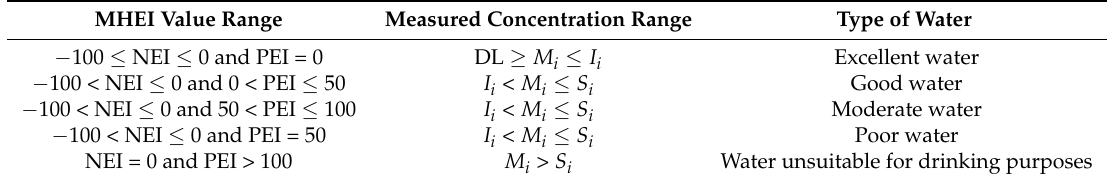
Table 2. Water quality classification based on the